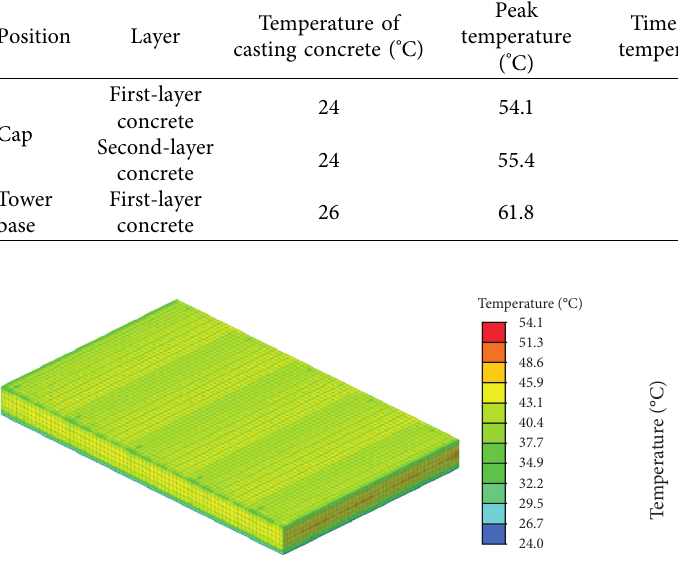
Figure 6: Distribution of the maximum temperature field on the first floor of cap (unit: ° C).